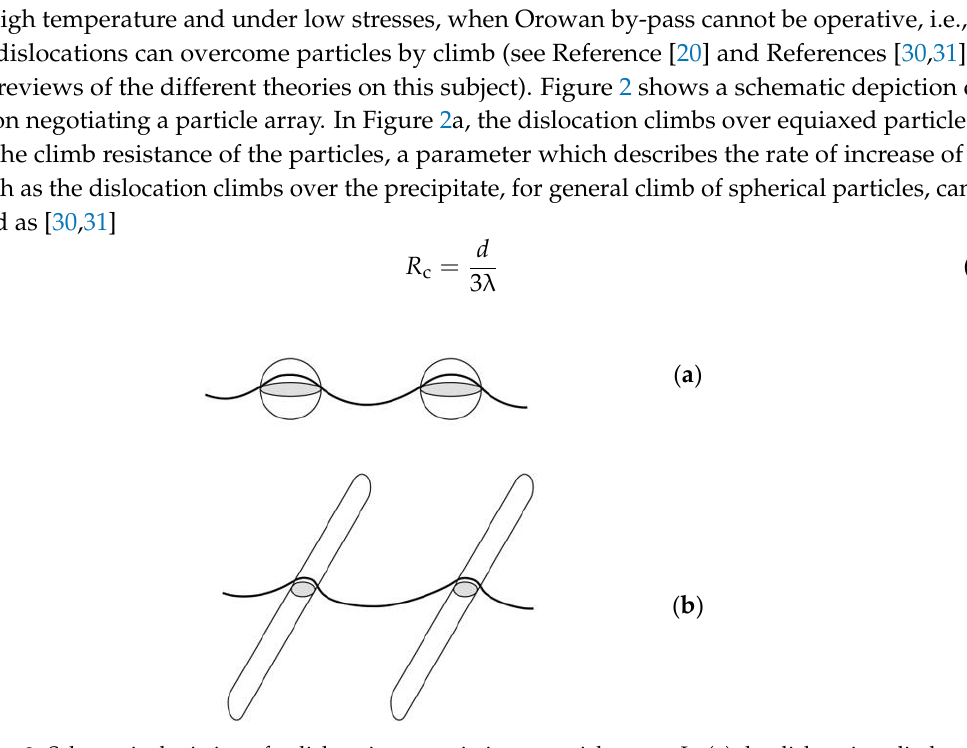
Figure 2. Schematic depiction of a dislocation negotiating a particle array. In ( a ) the dislocation climbs over equiaxed particles of size d s . In ( b ), the dislocation climbs over rods, of diameter d r = 1/3 d s , with the same volume and interparticle spacing on the slip plane of the equiaxed precipitates in (a). The rod axis forms an angle ϕ with the slip plane.